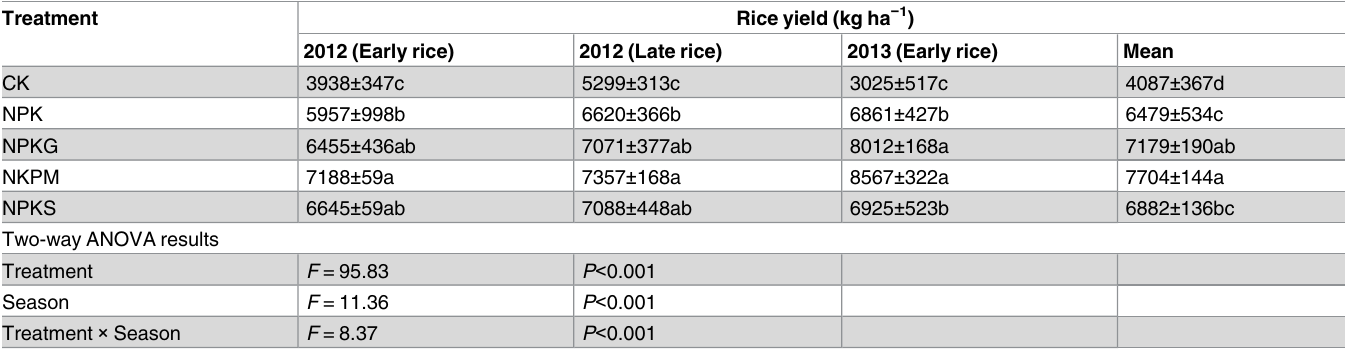
Table 3. Variations in rice yield under different fertilizations in 2012 and